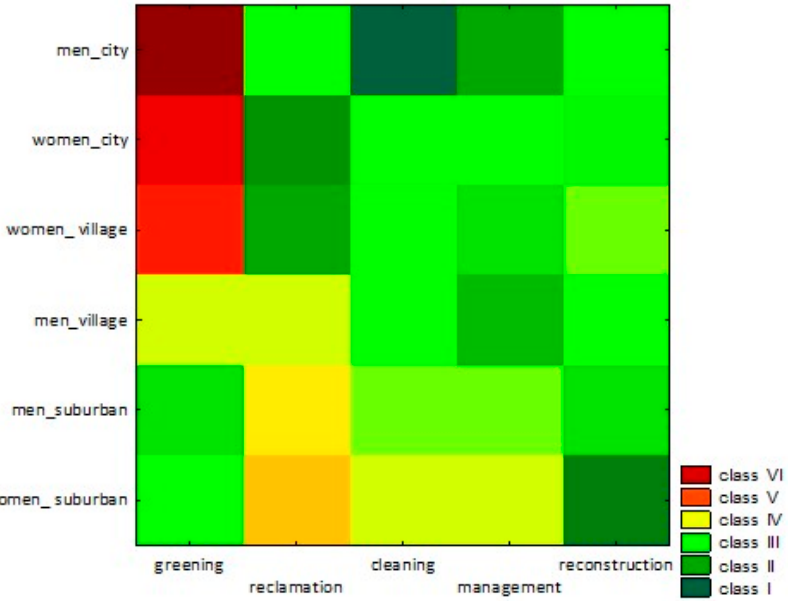
Figure 12. Standardized assessment of possible actions aimed at improving the landscape in relation to the five most common features depending on the gender and place of residence (EnvEng and CivEng students combined, n = 244).